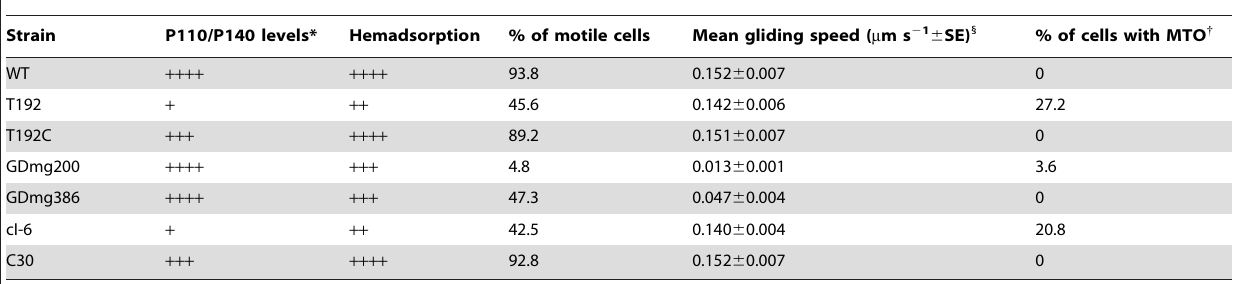
Table 1. Phenotypes of the analyzed strains.